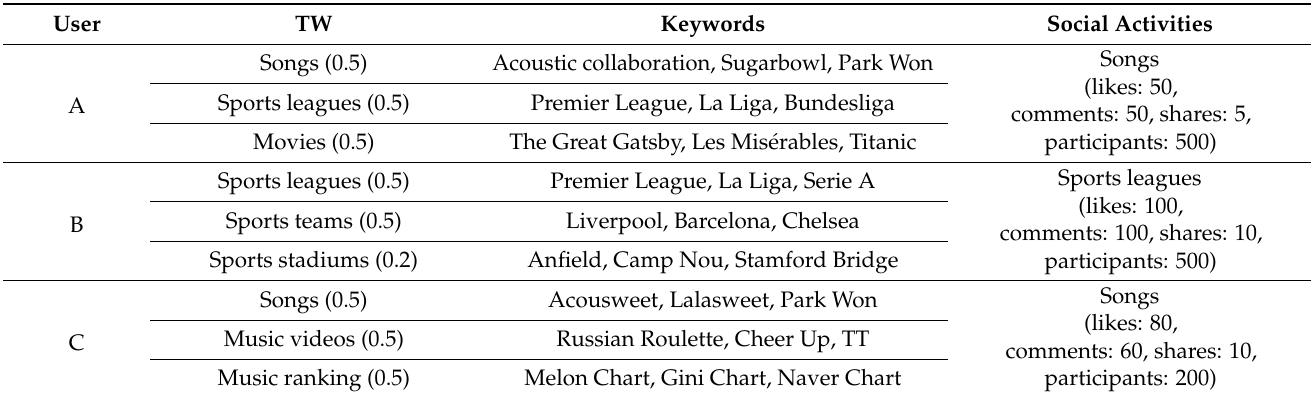
Table 1. Preferences and social activities of